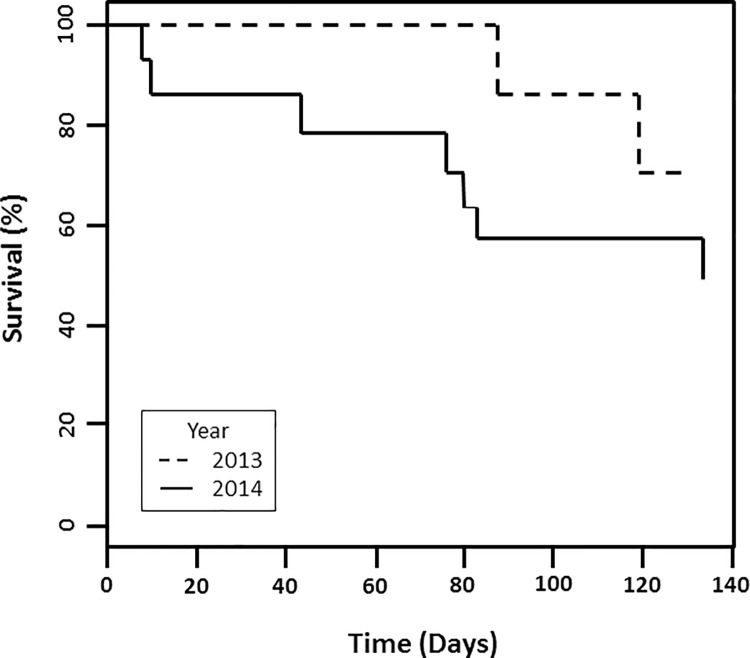
Kaplan-Meier breeding season survival curve for years 2013 and 2014.